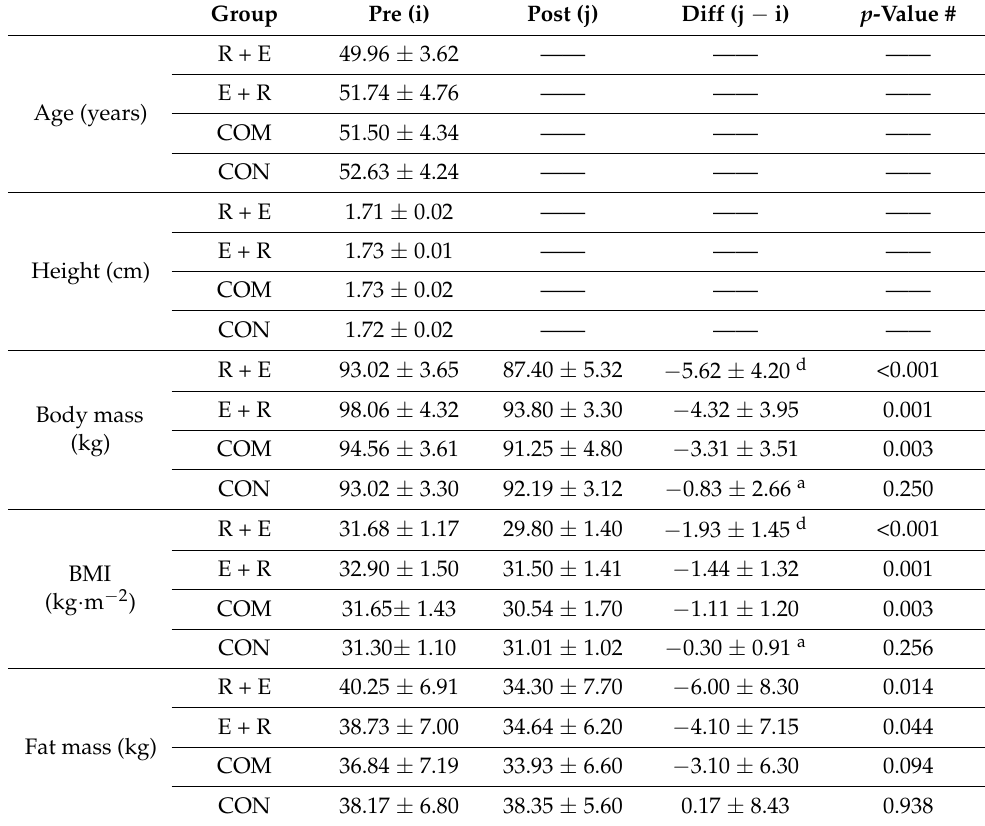
Table 1. Descriptive statistics of variables according to group and time